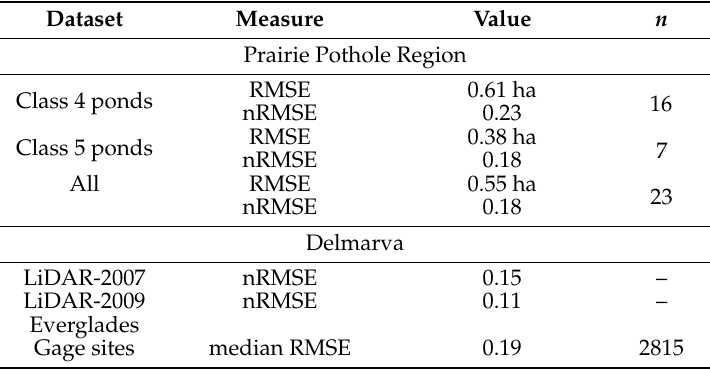
Table 6. Accuracy of surface water extent estimates at each of the three